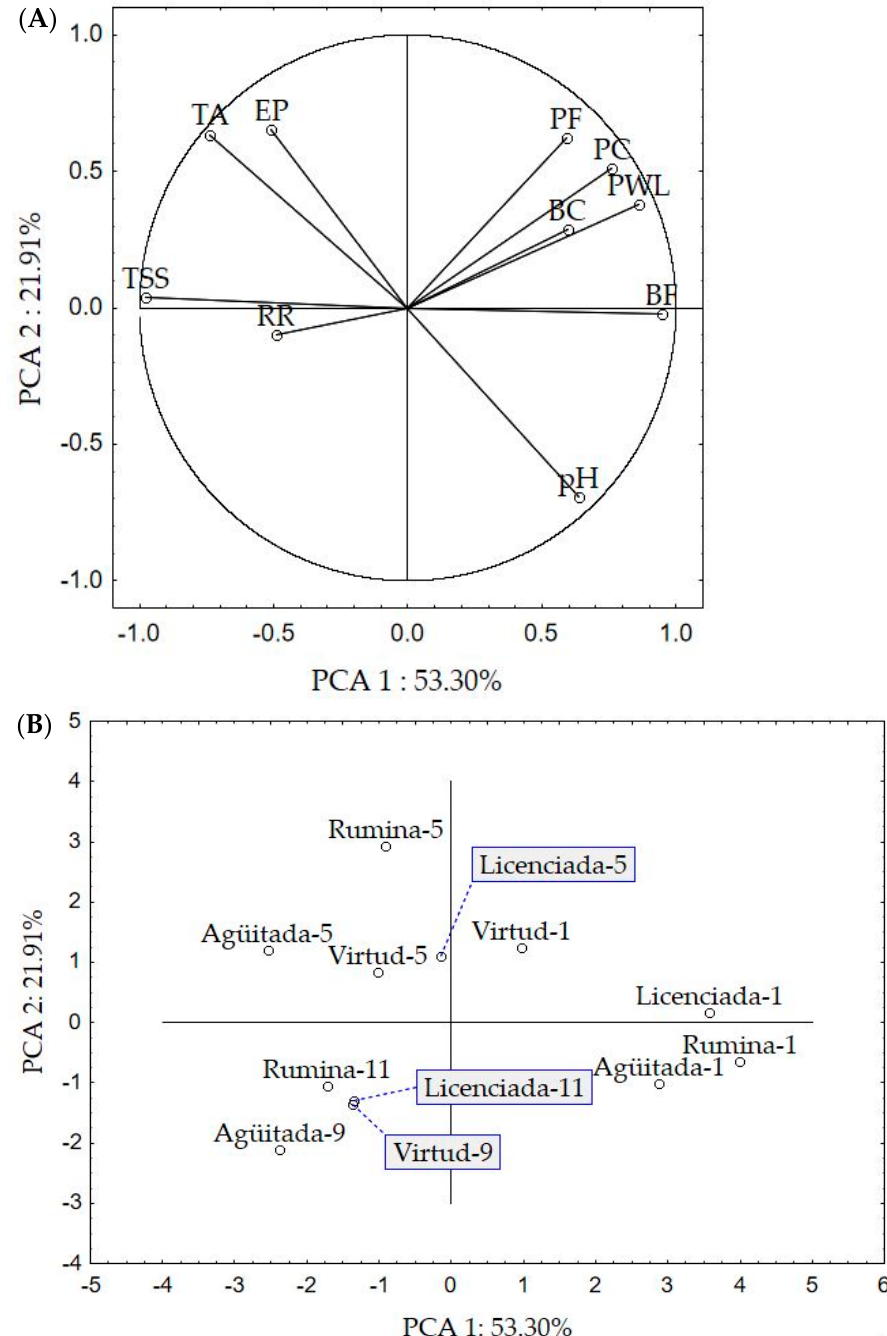
Figure 3. Principal component analysis of jackfruit genotypes evaluated on different days of storage; projection of variables ( A ) and projection of cases ( B ).